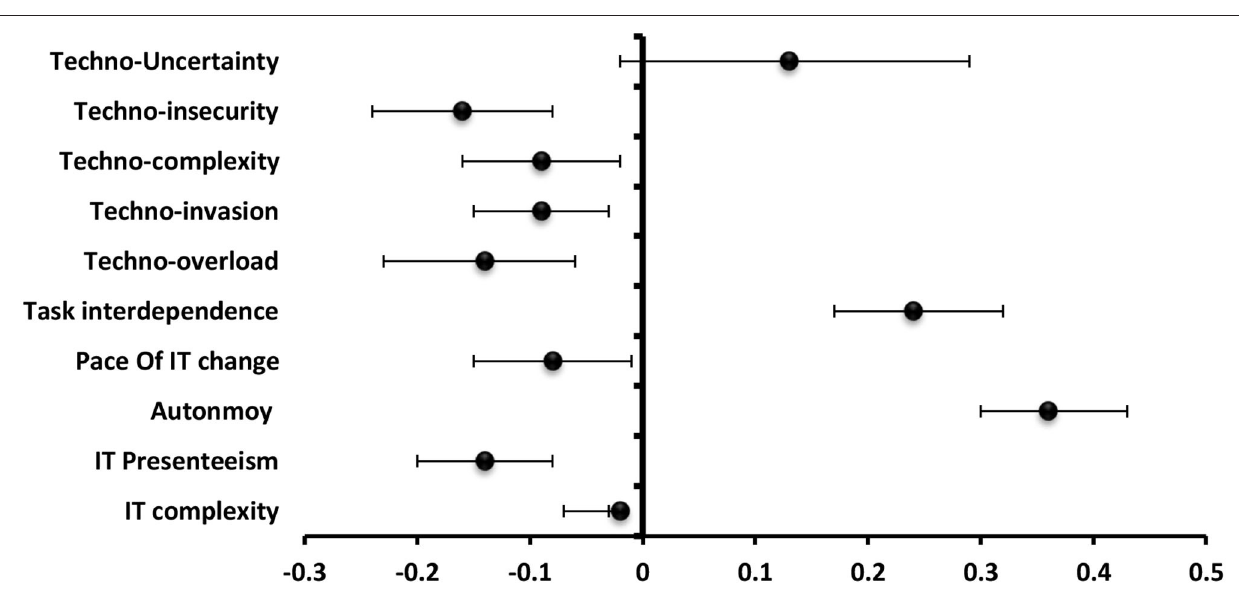
FIGURE 5 | Values of β and CI 95% for linear regression analysis of techno-stress items and job and technology characteristics as a predictor to engagement among staff.